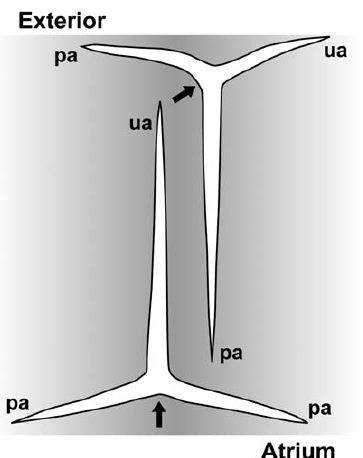
Figure 6. A pseudosagittal spicule and a subatrial sagittal spicule, shown in their orientation in the skeleton of Hetero- piidae. The arrows point at the unpaired angles. pa: paired actine; ua: unpaired actine. Pseudosagittal spicules have an appearance similar to sagittal spicules but their paired actines are of different sizes, with one being more similar to the unpaired actine than to the other paired actine. The latter points towards the atrium.